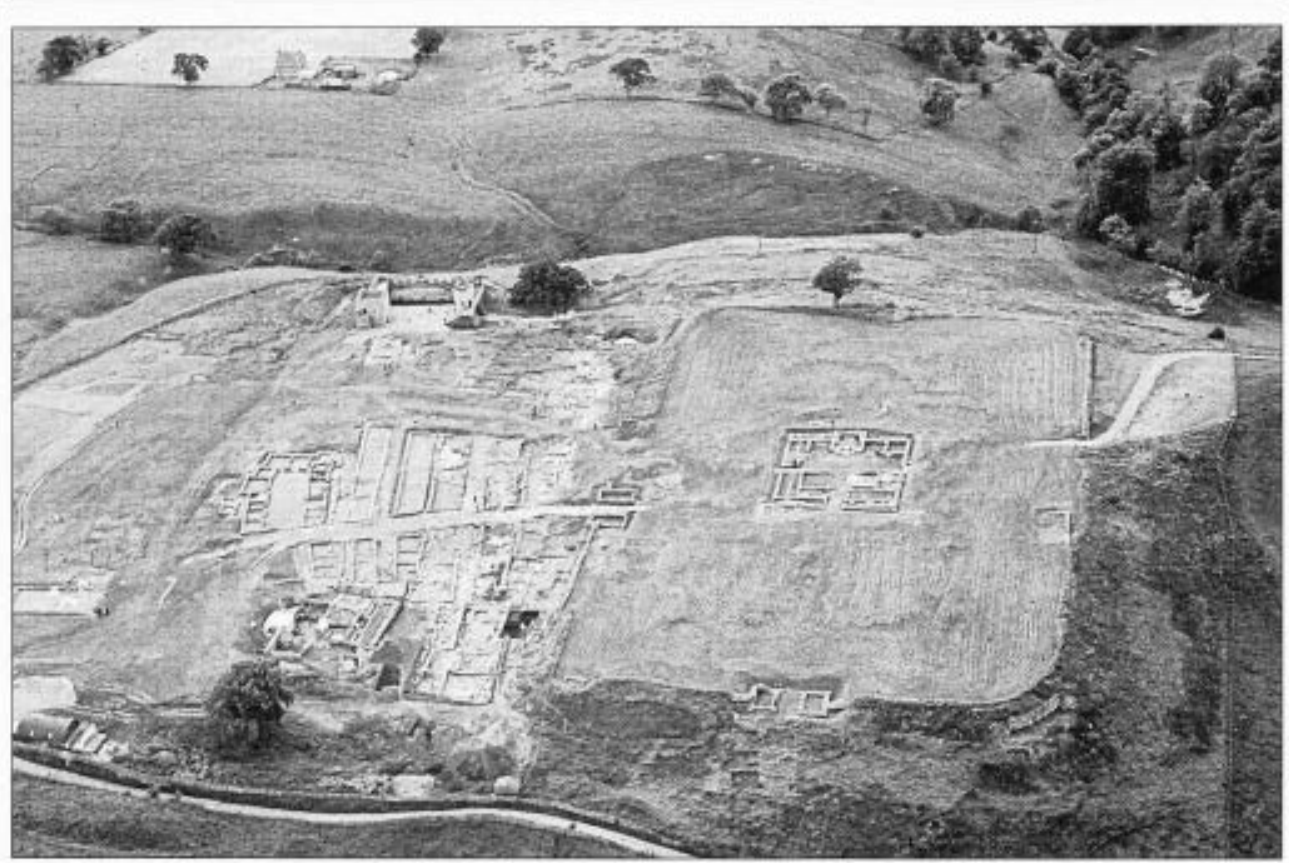
Figure 2 Aerial view of the Roman fort of Vindolanda (at present-day Chesterholm), looking north. A fort was first constructed late in the first century AD for a garrison of some 800 auxiliary infantry. The visible fort, dating from the second century, overlies the remains of earlier forts in which the writing tablets were